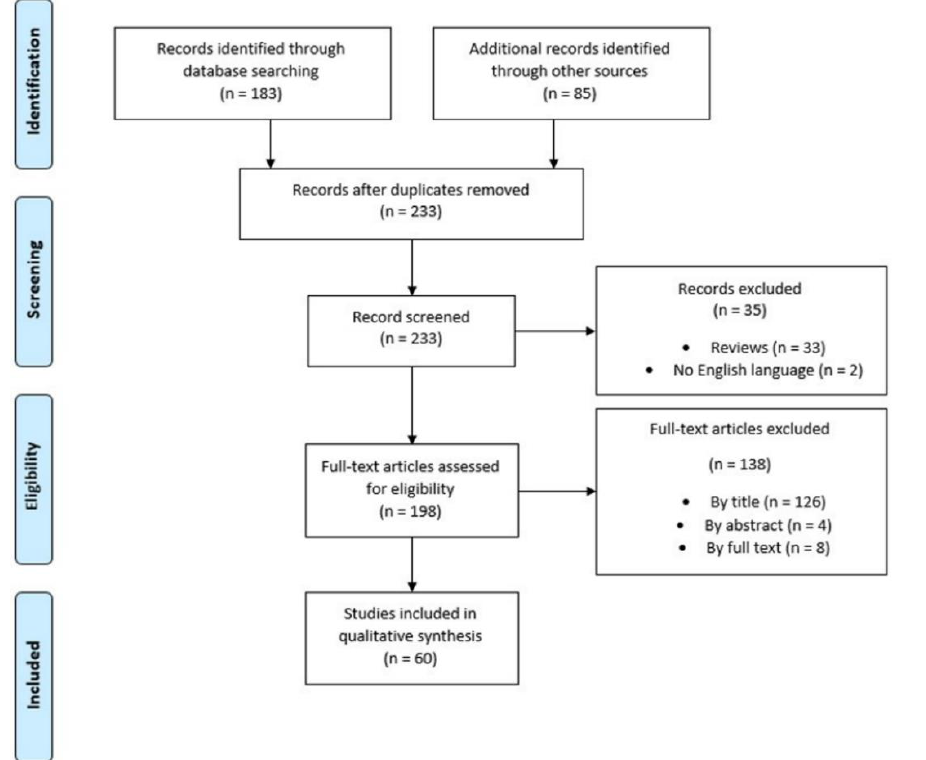
Figure 2. PRISMA flowchart related to the literature review.